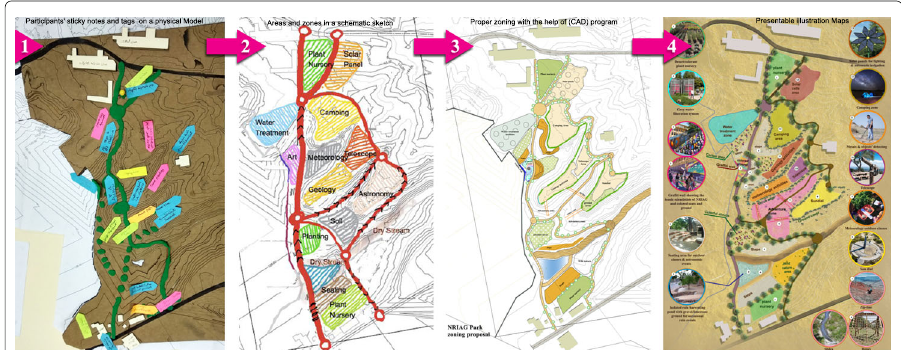
Fig. 2 The modelling progress of the proposed activities on the eco-park